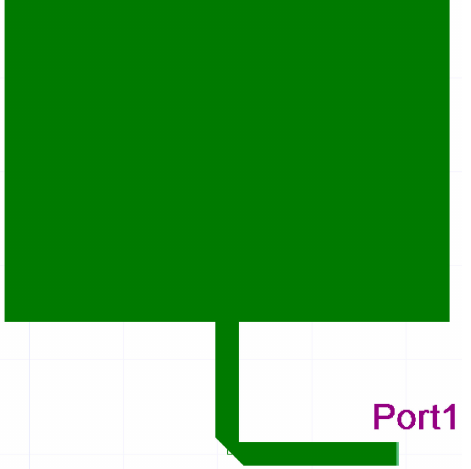
Figure 4. Single radiator Microstrip Planar Antenna (Ansys Designer model).